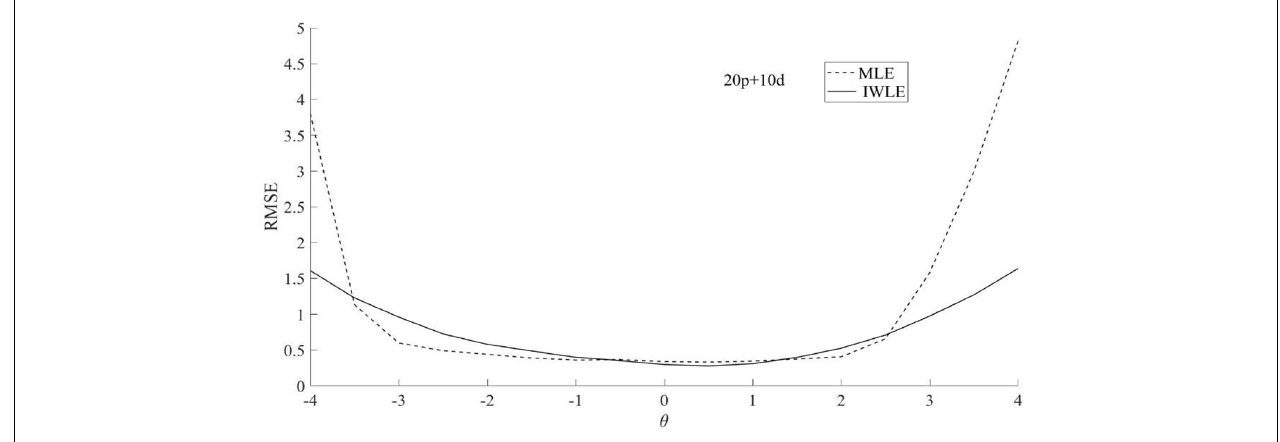
FIGURE 11 | RMSE of the two θ estimation methods MLE and IWLE for